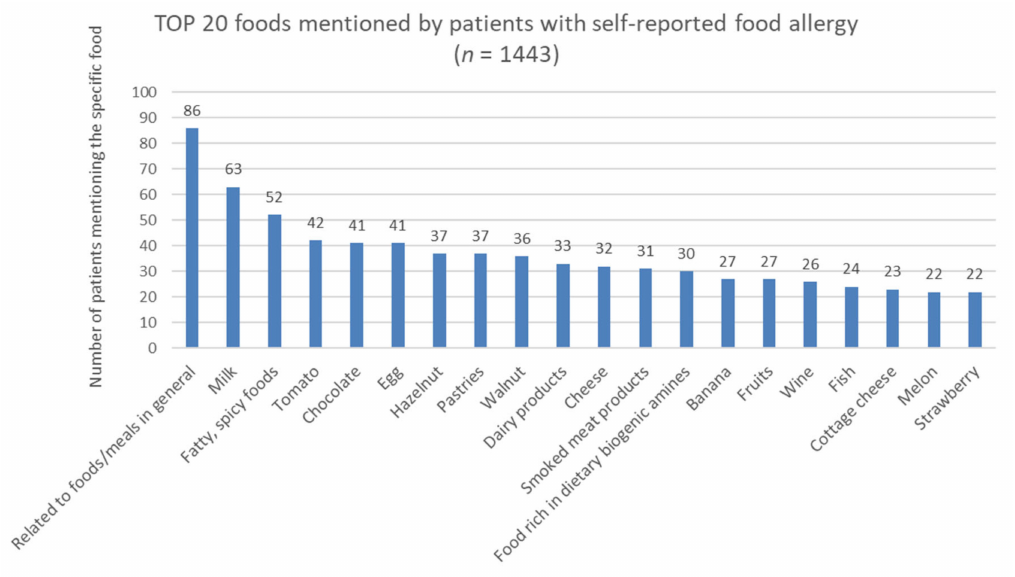
Figure 1. The 20 most commonly mentioned foods in the patient